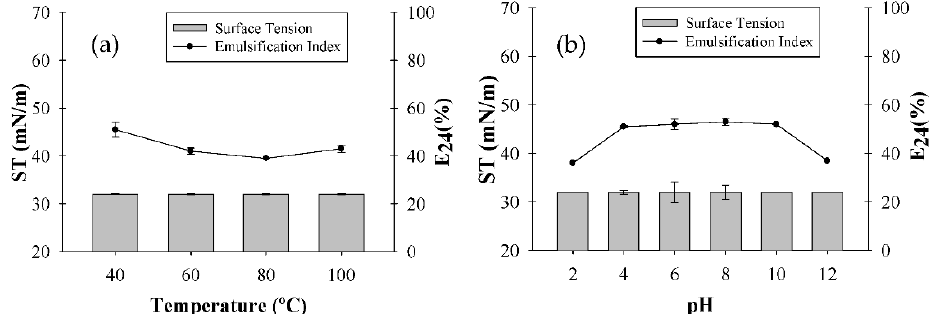
Figure 2. Influence of temperature ( a ) and pH ( b ) on Glycine max extract surface tension (ST) and emulsification index (E 24 ).